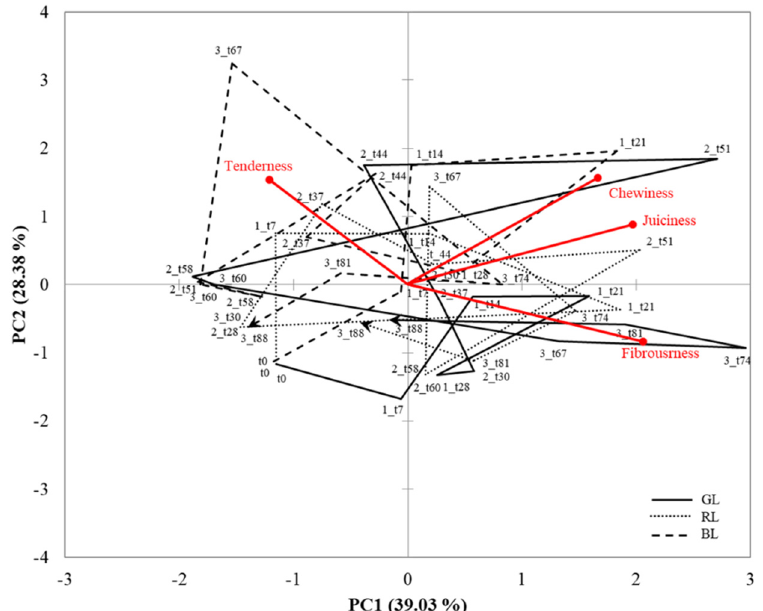
Figure 6. Principal Component Analysis representing the texture trajectories of the dry-cured loin samples (GL = green label, Cebo de Campo Ibérico dry-cured loin; RL = red label, Bellota 50% Ibérico dry-cured loin; BL= black label, Bellota 100% dry-cured loin) over the three intakes.